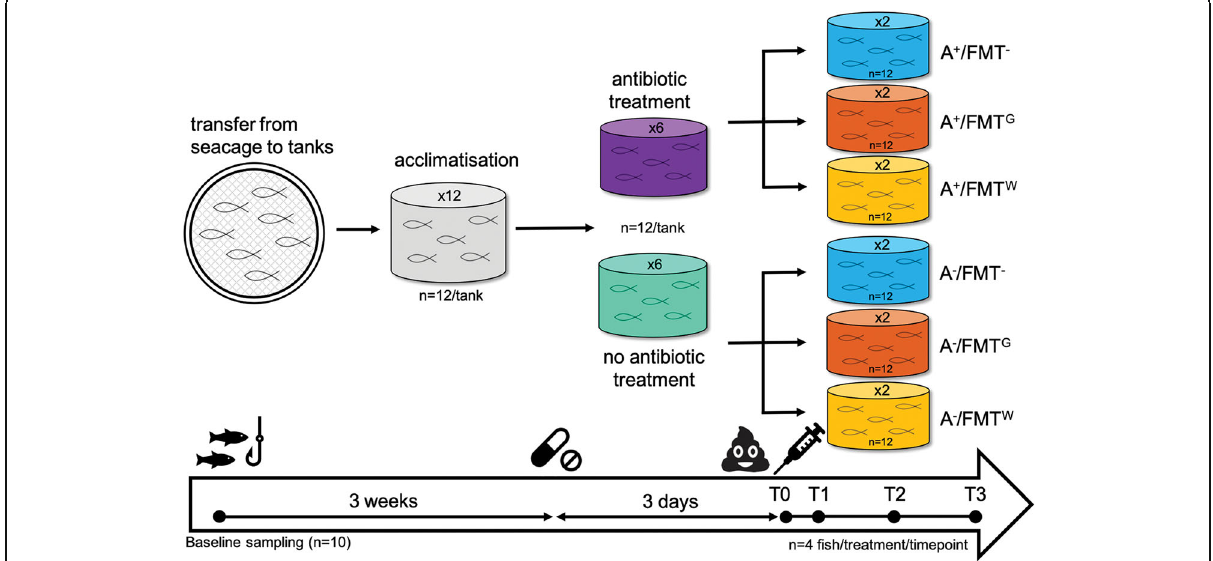
Fig. 1 Overview of the experimental design of the study. A total of 6 treatment groups were compared and included no antibiotic treatment with no faecal microbiota transplantation (A − /FMT − ); antibiotic treatment with no FMT (A + /FMT − ); no antibiotic treatment with FMT via gavage (A − /FMT G ); antibiotic treatment with FMT via gavage (A + /FMT G ); no antibiotic treatment with FMT via water (A − /FMT W ); and antibiotic treatment with FMT via water (A + /FMT W ). Each treatment was replicated across 2 tanks. Antibiotic treatment was administered by oral gavage 3 days prior to FMT, with sampling conducted at: T0 = immediately prior to FMT; T1 = 2 days post FMT; T2 = 8 days post FMT; and T3 = 15 days post